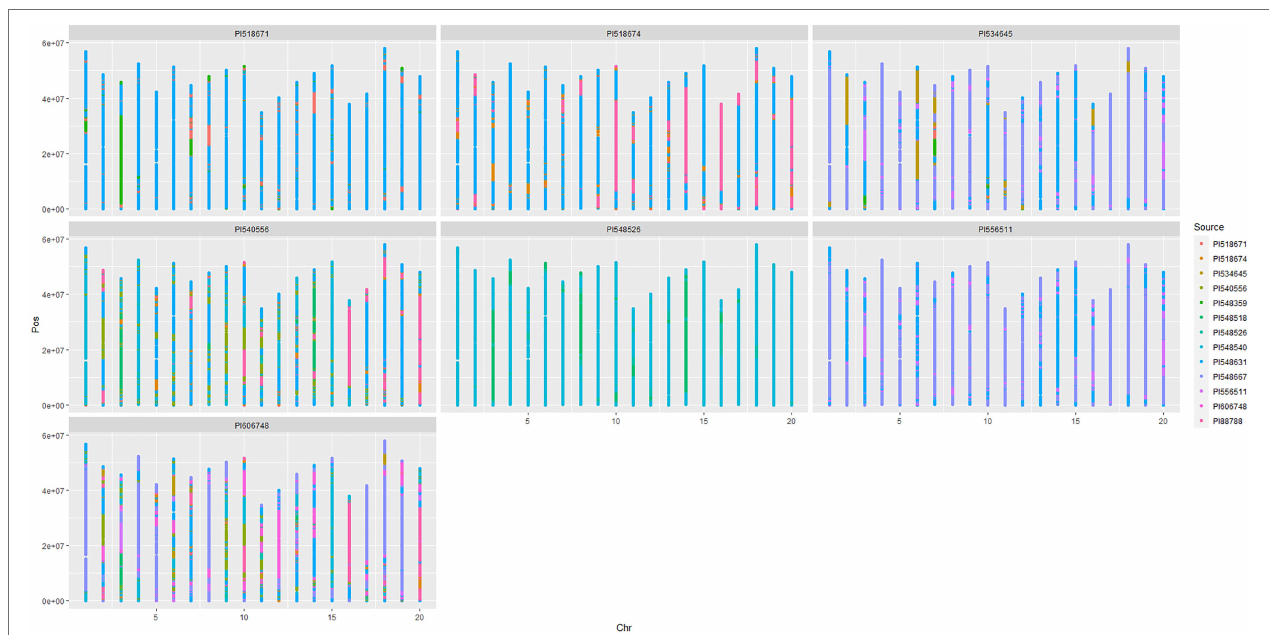
FIGURE 2 | Scatterplot maps of chromosome segments inherited from ancestral sources, traced through progenitors of soybean cultivar Rend (i.e., PI606748). Chromosome number (based on Wms82.a2 reference genome) is plotted left to right on the x-axis, while position is plotted on the y-axis increasing bottom to